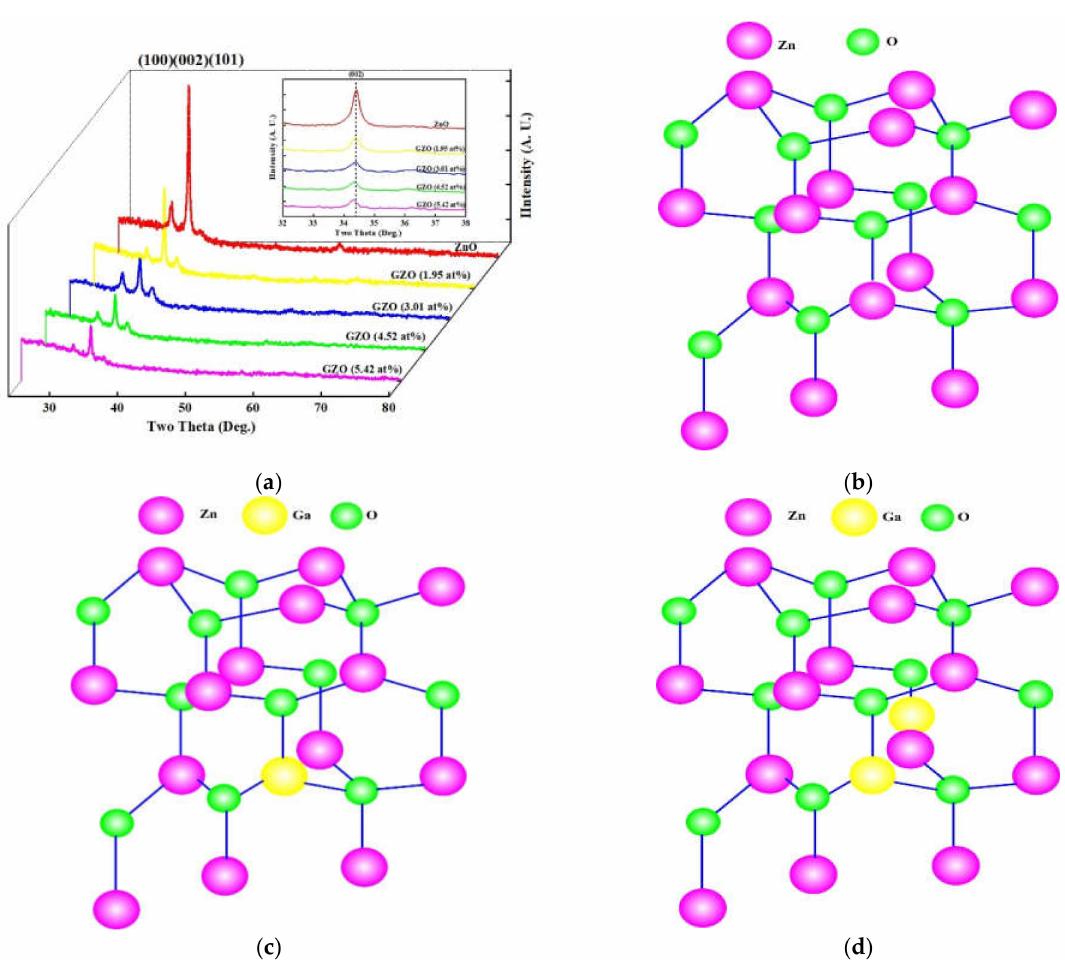
Figure 4. ( a ) XRD spectra of MIPEMOCVD-grown GZO thin films with varying Ga content and the schematic crystal structure for ( b ) ZnO, ( c ) GZO with substituted Ga atoms (Ga contents of 1.95 and 3.01 at%), and ( d ) GZO with interstitial Ga atoms (Ga contents of 4.52 and 5.24 at%). Table 3. The 2 θ angle and FWHM of (002) peak of XRD spectra and calculated grain size for ZnO and MIPEMOCVD-grown GZO with varying Ga content. Ga Content